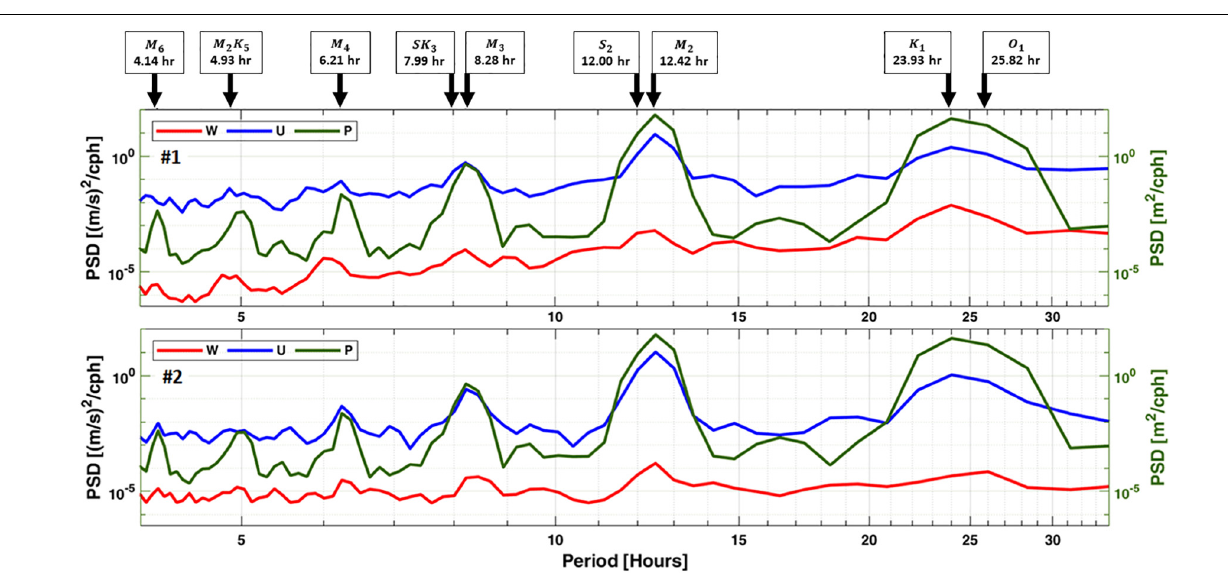
FIGURE 4 | Power spectral density (PSD) of horizontal (blue) and vertical (red) velocities, computed as the average of all vertical cells, and pressure (green) between 15 and 27 July 2017. Black arrows indicate tidal constituents during elevated PSD